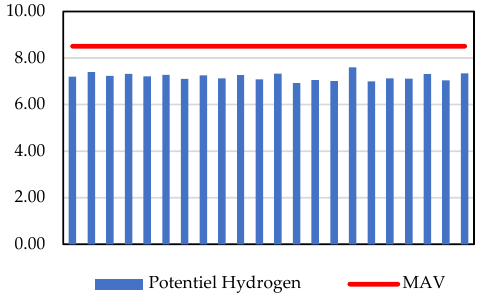
Figure 9. pH of the groundwater in the T.O.C. (March 2017).